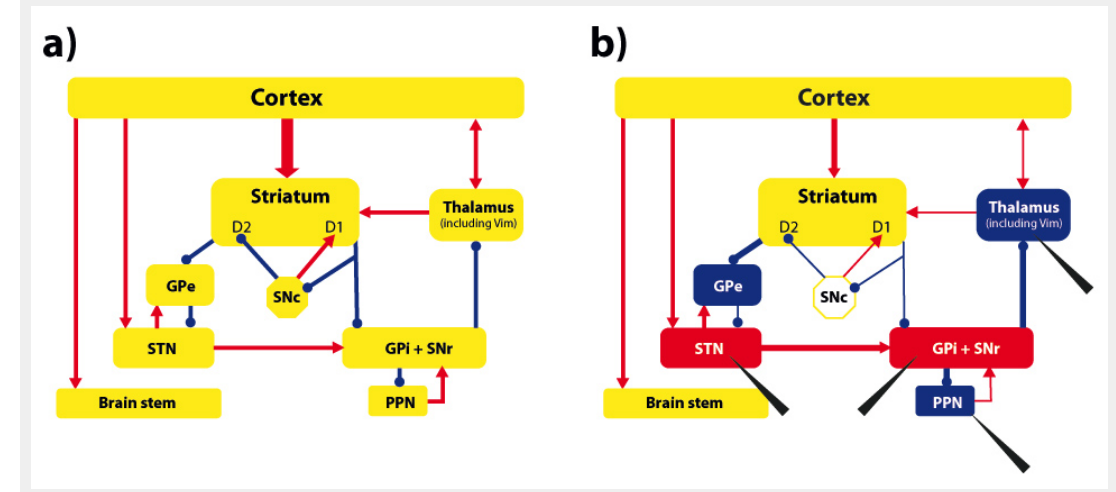
A simplified scheme of the basal-ganglia and thalamo-cortical network responsible for movement control (based on [39, 40]). Part a) shows the functional network, where red lines stand for excitatory and blue lines for inhibitory connections. Part b) shows the dysfunctional network resulting from a loss of dopaminergic neurons in the Substantia nigra pars compacta (SNc). Network nodes in red color indicate hyper- activation, nodes in blue color hypo-activation. D1/D2: sub-populations of neurons in the striatum; GPe: Globus pallidus externus; STN: Nucleus subthalamicus; GPi: Globus pallidus internus; SNr: Substantia nigra pars reticulate; PPN: Nucleus pedunculopontinus ; Vim: ventral intermediate part of Thalamus (Vim). Black arrowheads indicate potential DBS targets in which quadripolar electrodes are stereotactically implanted. The electrodes are connected to a pulse generator (usually placed under the skin in the subclavicular or abdominal area) that controls several parameters of the chronically applied electrical stimulation (frequency, pulse width, and amplitude). The intervention is usually made in the alert patient, as active cooperation by the patient is required for evaluating target accuracy and stimulation benefit while the electrodes are